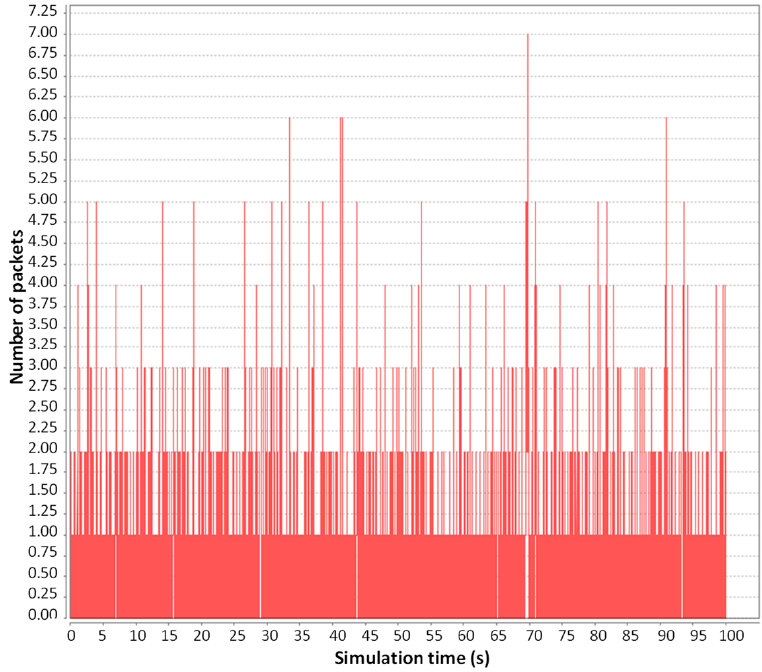
Figure 10. Volume of transmitted messages.